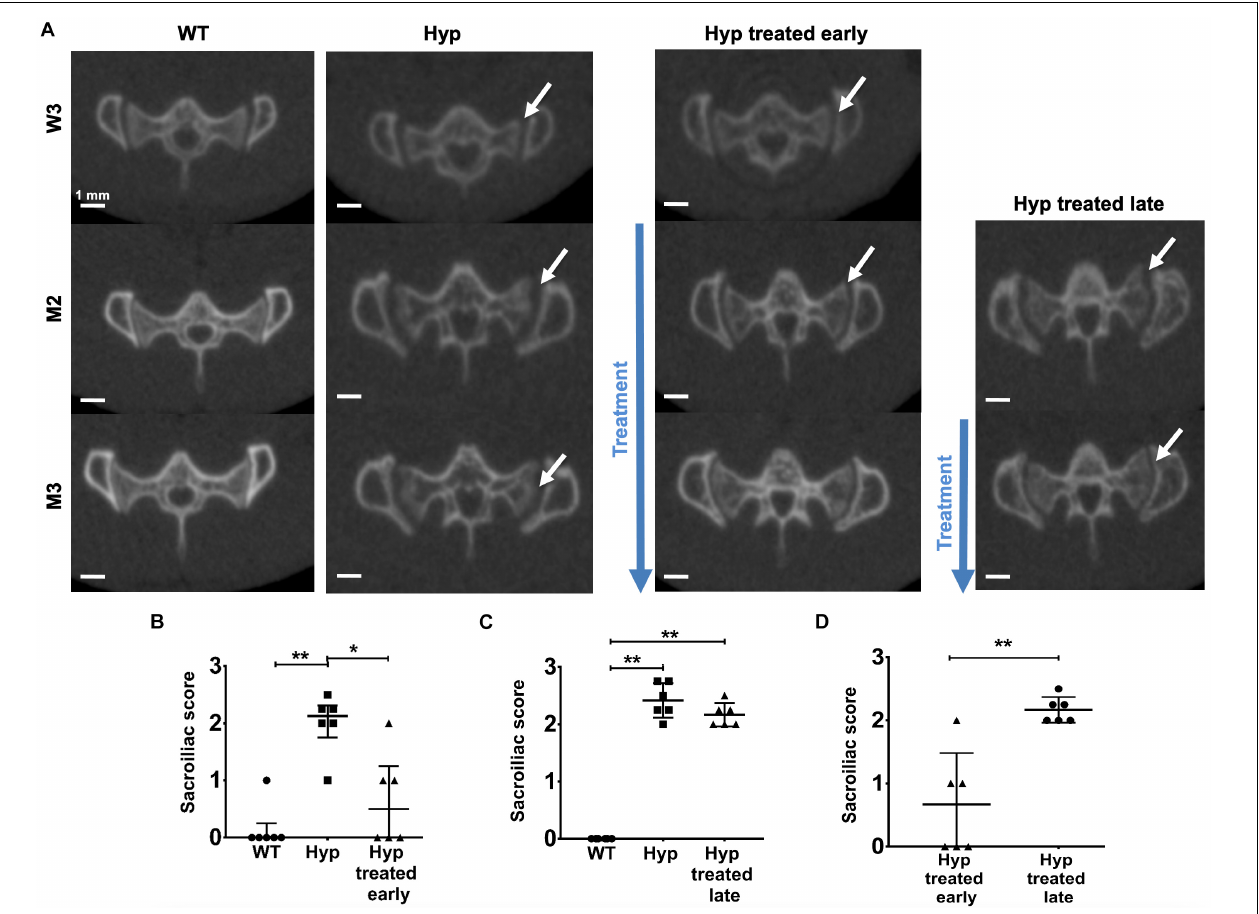
FIGURE 3 | Micro-CT evaluation of sacroiliac joints at W3, M2, and M3 in WT mice, untreated Hyp mice and Hyp mice on conventional treatment started early or late. (A) Multiple erosions and irregular cortical margins of sacroiliac joints are indicated with arrows in untreated Hyp mice. In Hyp mice on conventional treatment started early, there is improvement in extraskeletal manifestations at M2 and M3, but without complete restoration ad integrum . No improvement in extraskeletal manifestations is noticeable in Hyp mice on conventional treatment started late. Sacroiliac score evaluated at Micro-CT scans at M3 (B) in WT mice, untreated Hyp mice, and Hyp mice on conventional treatment started early, (C) in WT mice, untreated Hyp mice, and Hyp mice on conventional treatment started late, and (D) in Hyp mice on conventional treatment started early compared to Hyp mice on conventional treatment started late. W3: 3 weeks; M2: 2 months; M3: 3 months; * p < 0.05; ** p <